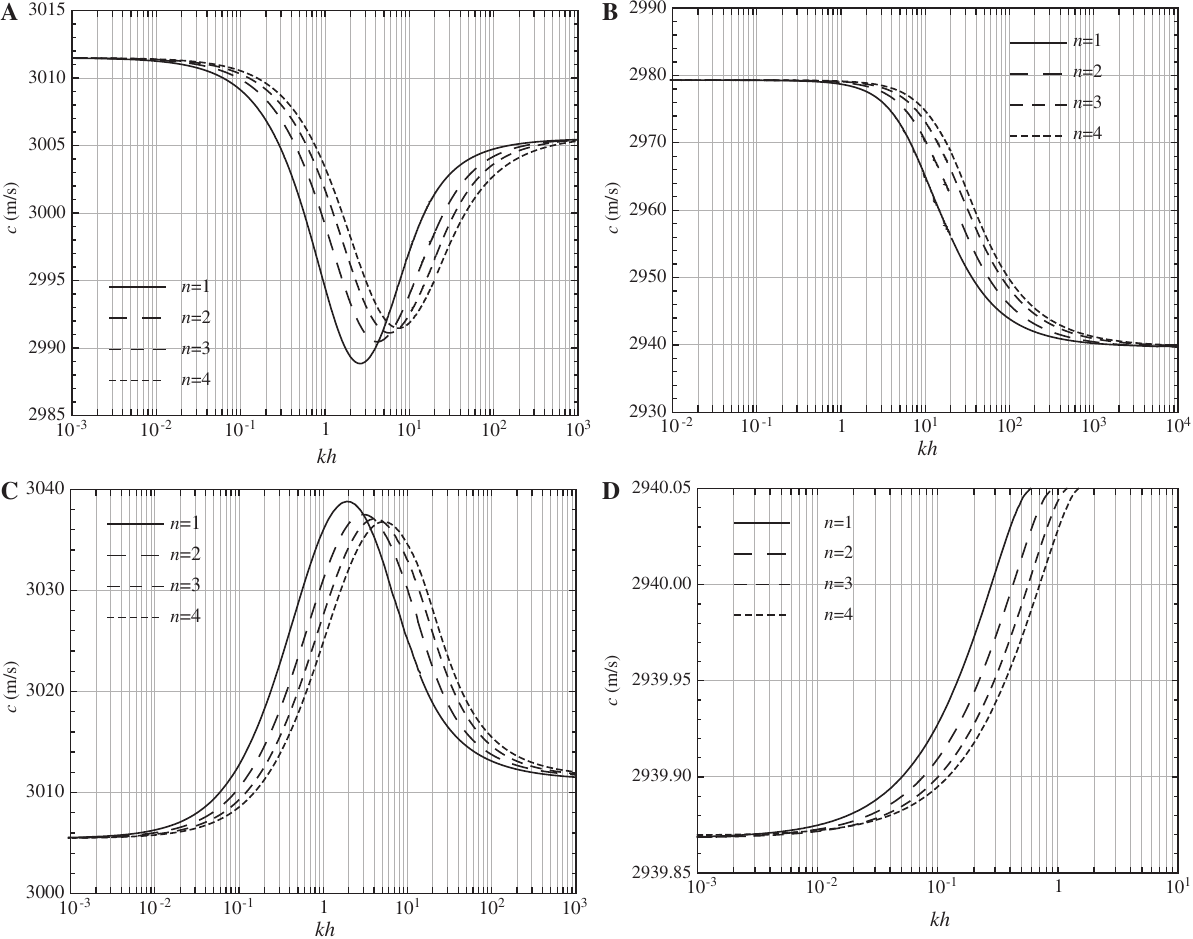
Figure 6: Dispersion curves corresponding to an inhomogeneous MEE layer for different values of variation power, n : (A) G1, (B) G2, (C) G3, (D)